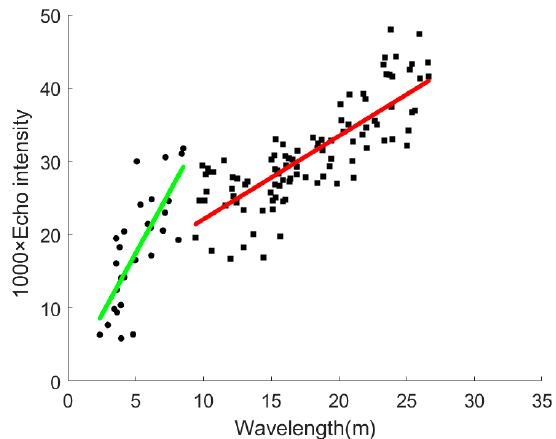
Figure 21. Morphological relationship of wave length estimation versus local maxima echo intensity for sand waves.